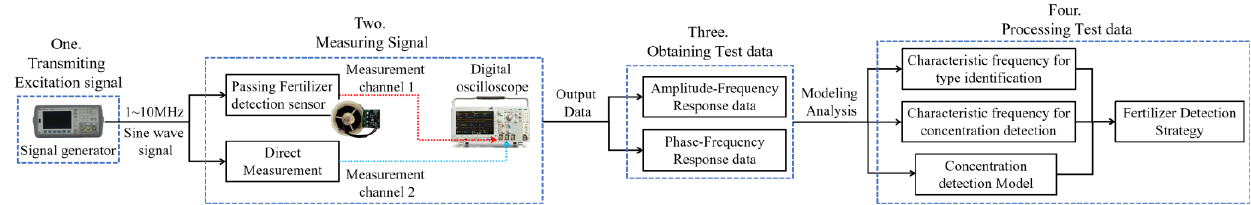
Figure 3. The schematic diagram of the